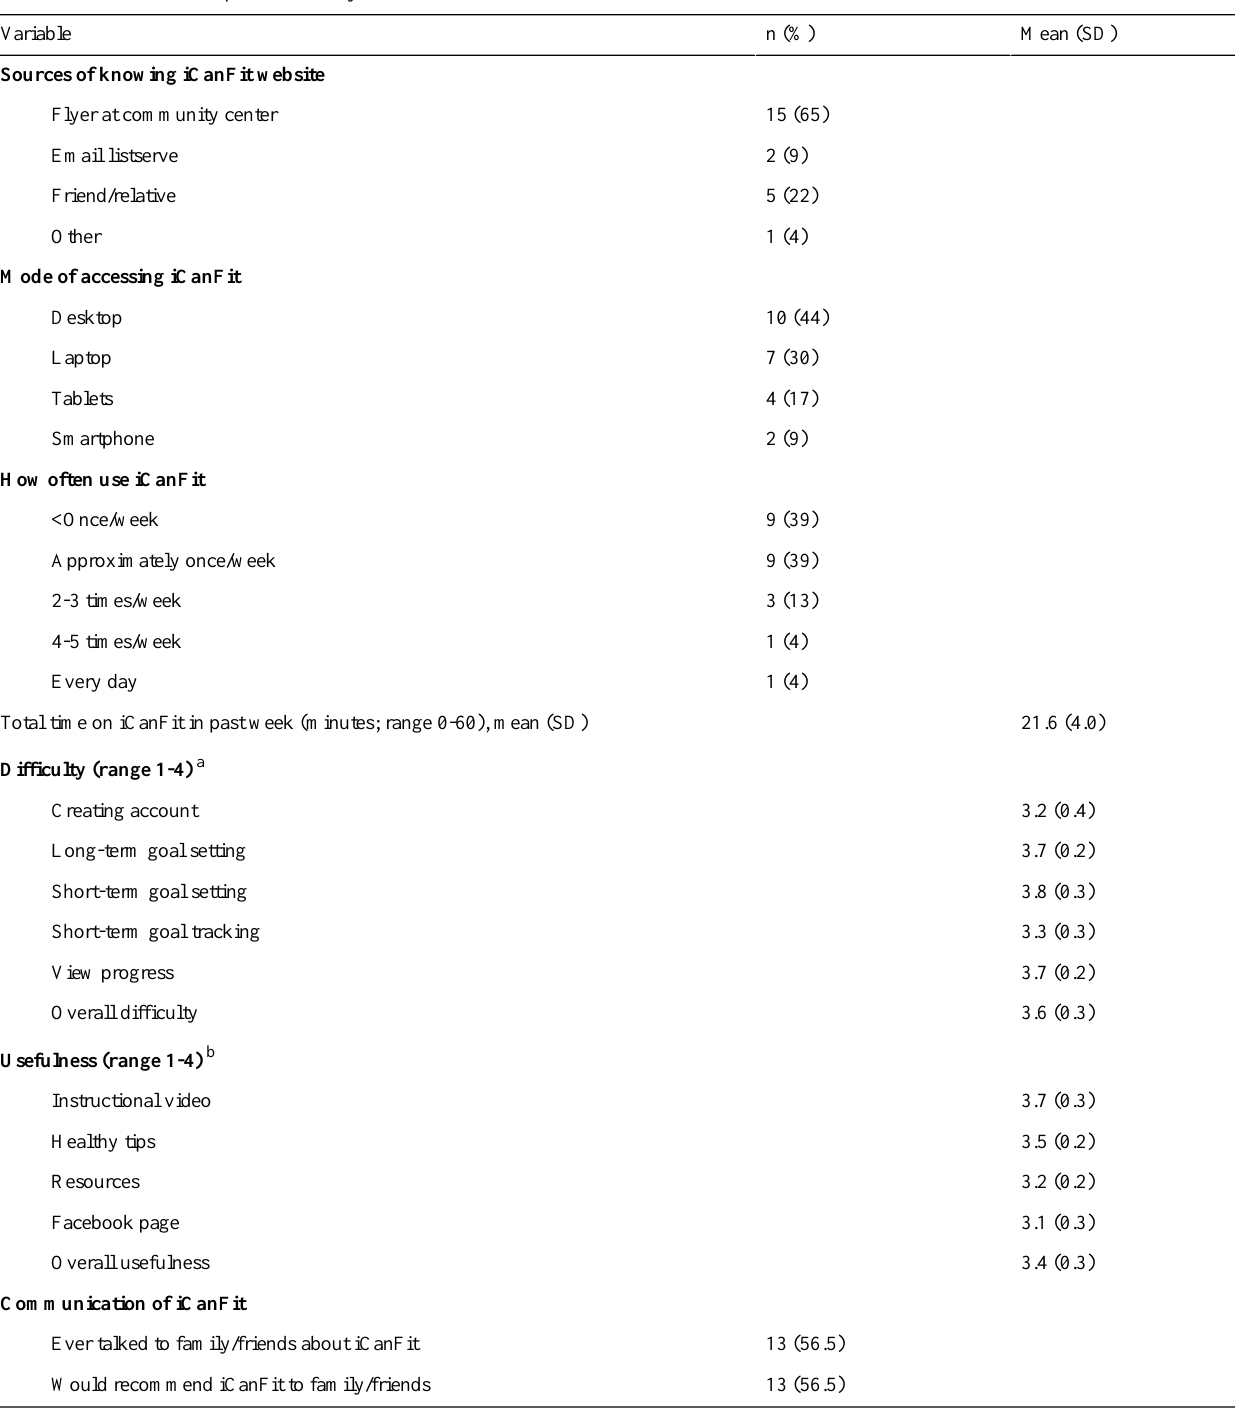
Table 3. Results of user-experience survey